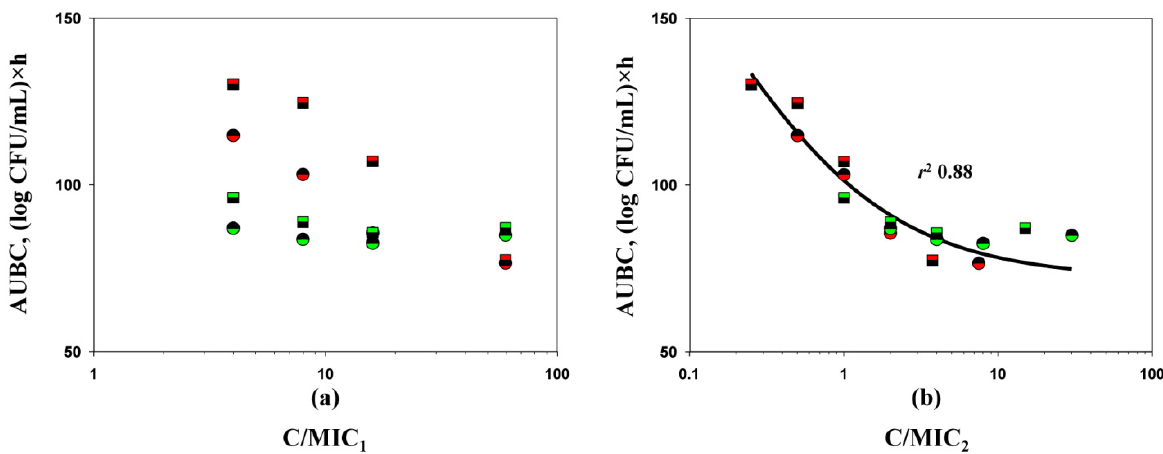
Figure 4. C/MIC 1 ( a ) and C/MIC 2 ( b )-dependent antimicrobial effects (expressed as AUBCs) of imipenem (circles) and doripenem (squares) in combination with relebactam on K. pneumoniae 16 (red color) and K. pneumoniae ATCC BAA-1902 (green color) in time-kill experiments (MIC 1 —MIC S obtained with the traditional method; MIC 2 —MIC S obtained with the PK-based method). The relationship fits by Equation (1): Y 0 = 72.00, x 0 = 1.412, a = 155.4, b = -0.5838.